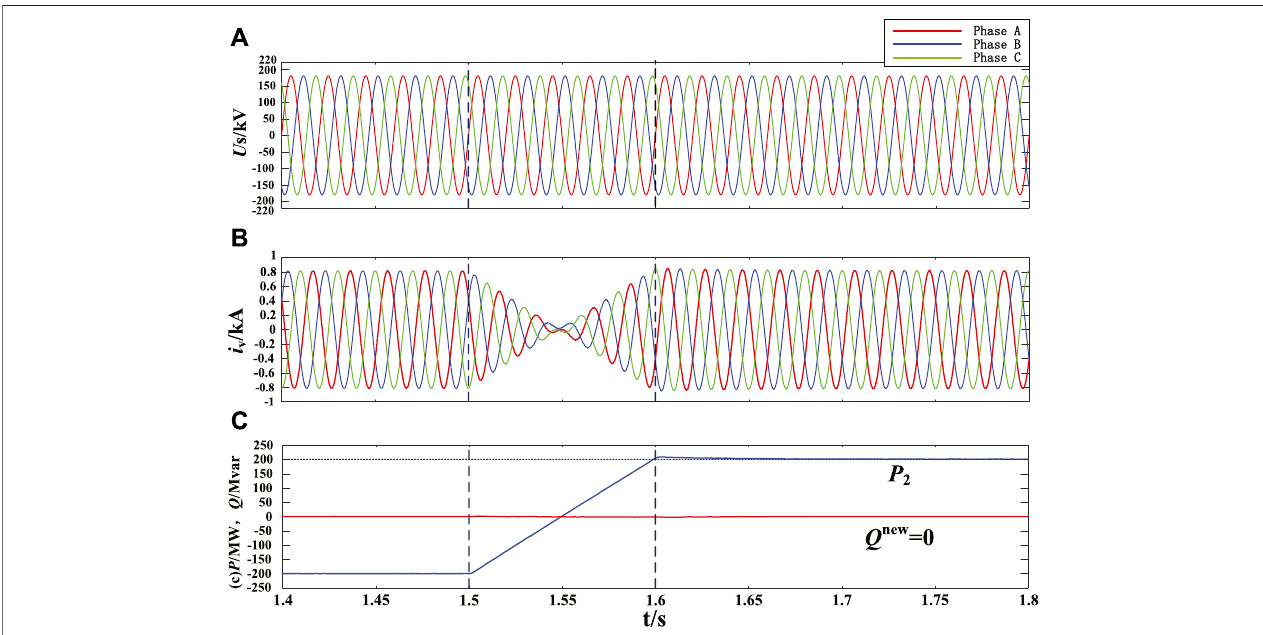
FIGURE 5 | Simulation results under balanced grid condition, (A) AC grid voltage at MMC 2 side, (B) AC grid current output by MMC 2 , (C) active power and ERP output by MMC 2 using the novel